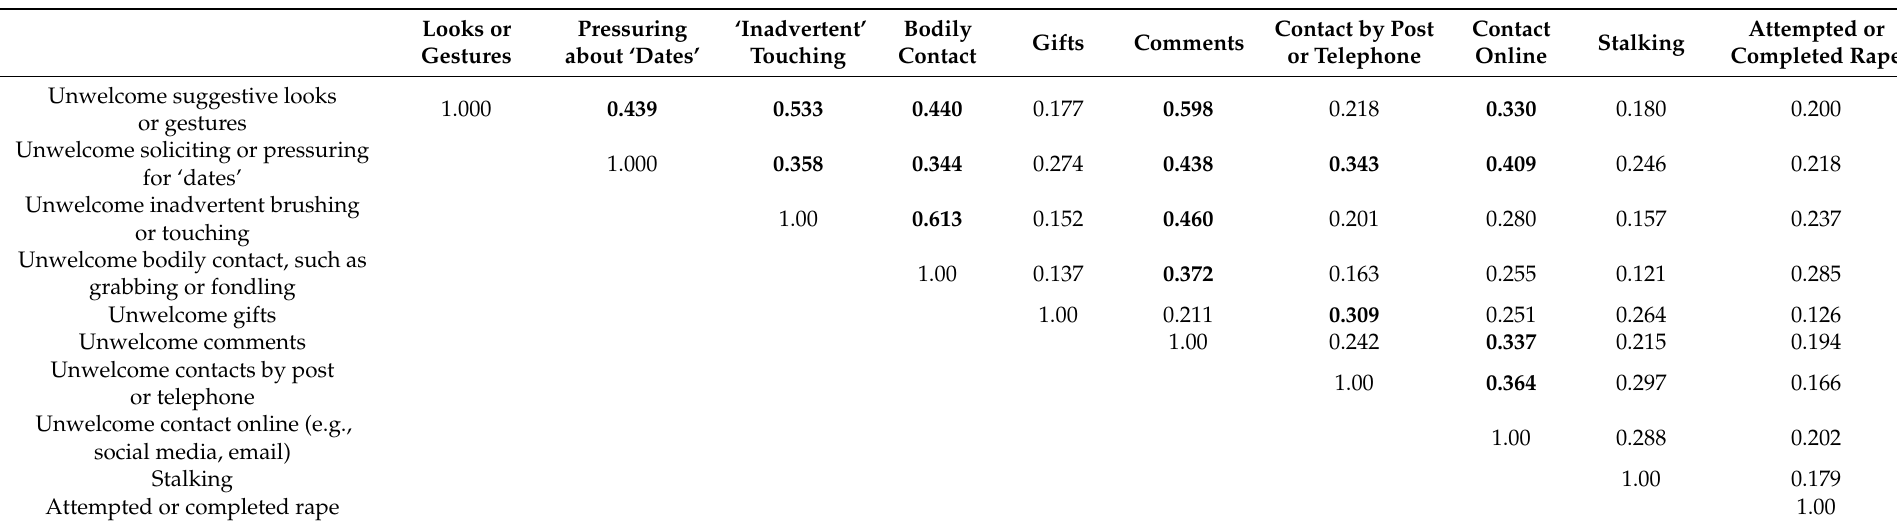
Table 3. Spearman’s correlations * between all 10 types of sexual harassment experiences. Tellus survey, N = 12,403. Looks or Pressuring ‘Inadvertent’ Bodily Gifts Comments Gestures about ‘Dates’ Touching Contact